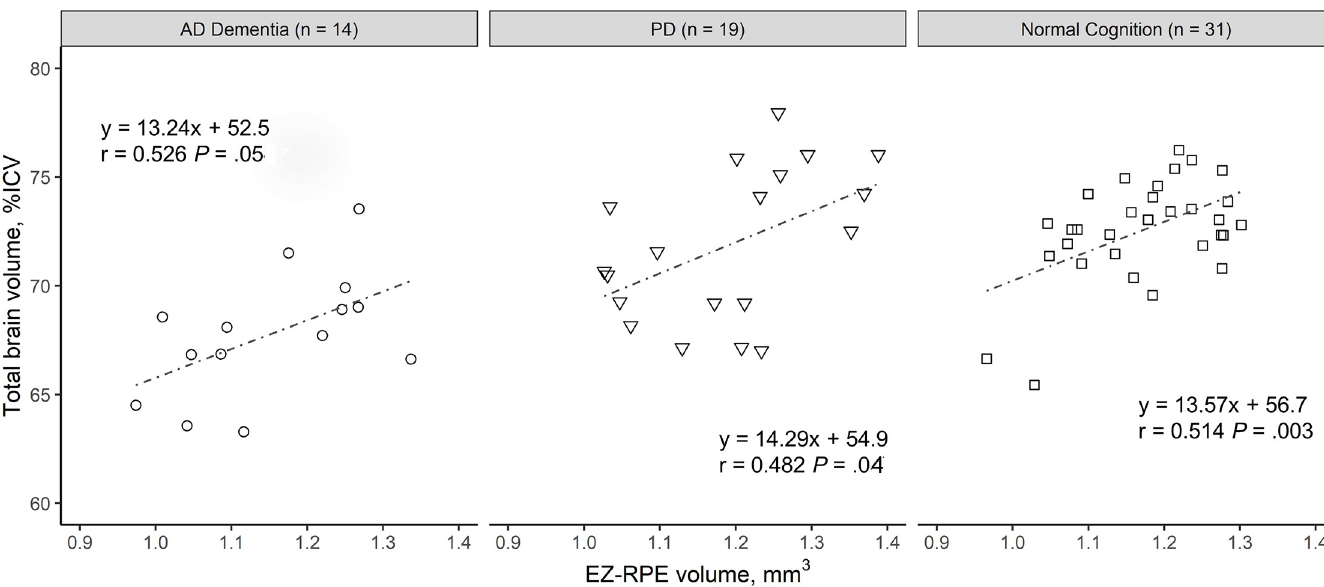
Fig 3. Correlation of total brain volume and ellipsoid zone (EZ) to retinal pigment epithelium (RPE) volume. A scatter plot showing the positive correlation between EZ-RPE volume and total brain volume (%ICV) in each diagnostic group. The correlation is statistically significant in Parkinson’s disease group (Pearson correlation coefficient 0.482, P = .04), normal cognition control group (Pearson correlation coefficient 0.514, P < .01) and marginally significant in Alzheimer’s disease dementia group (Pearson correlation coefficient 0.526, P = .05).